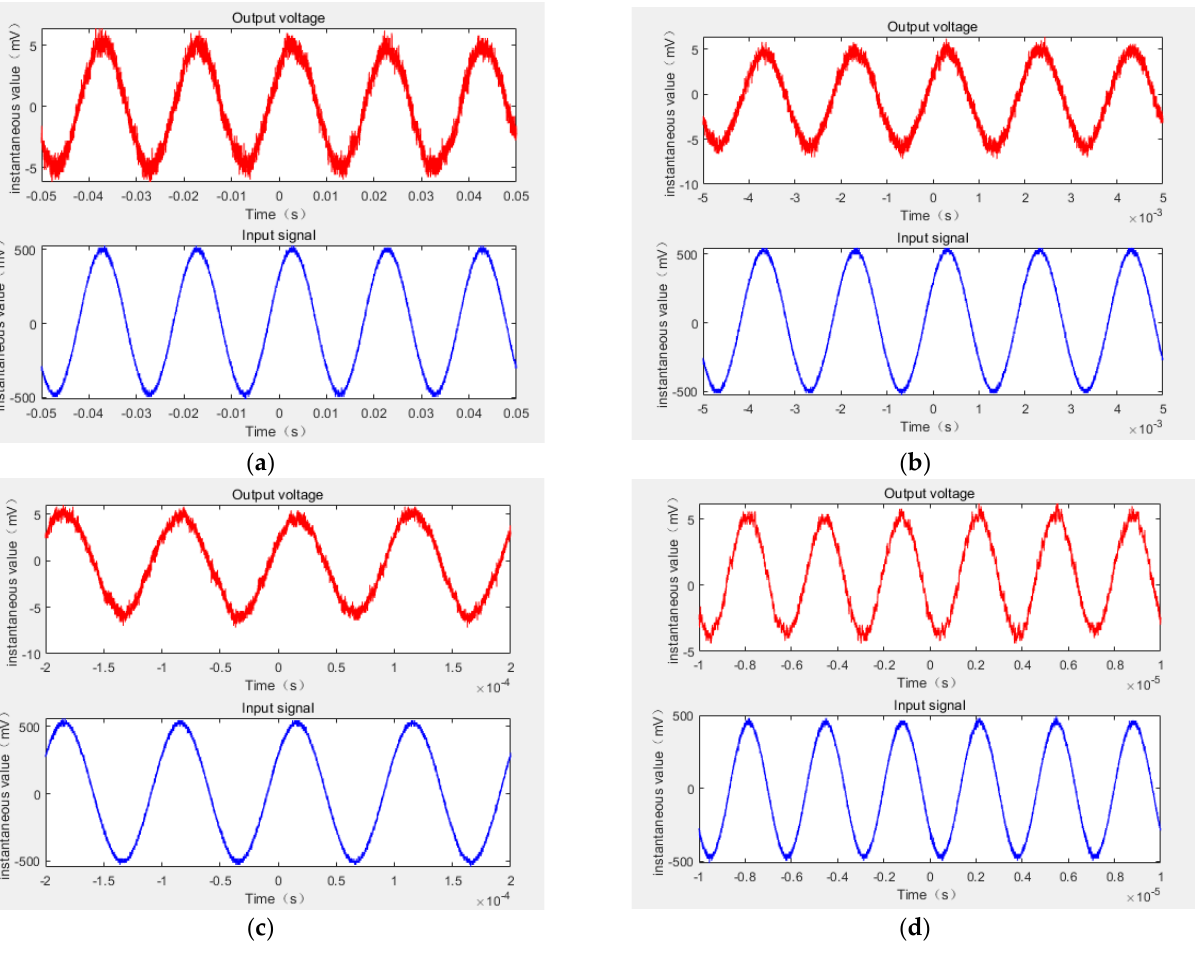
Figure 22. Comparison of the AC input and output of non-contact composite broadband current sensors. ( a ) 50 Hz AC input and output waveform, ( b ) 500 Hz AC input and output waveform, ( c )